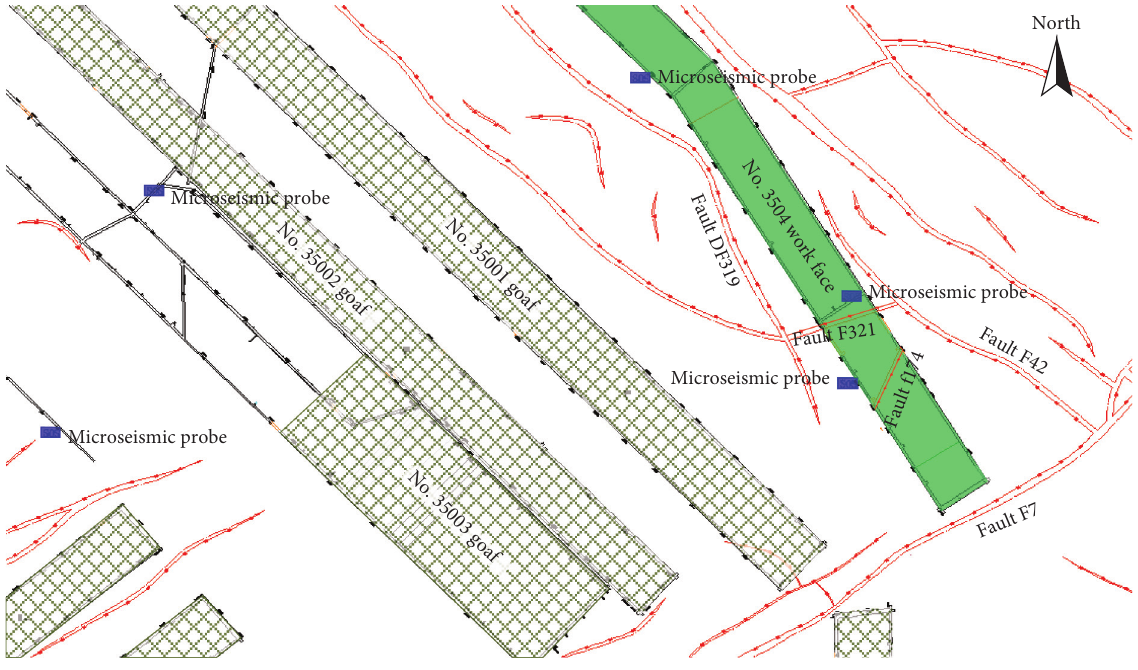
Figure 1: Relative position of working